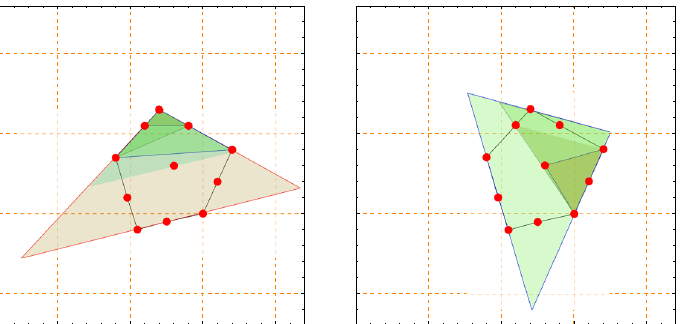
Figure 13. Results produced by the proposed algorithm applied to a set of PS6 points close to the points indicated in Figure